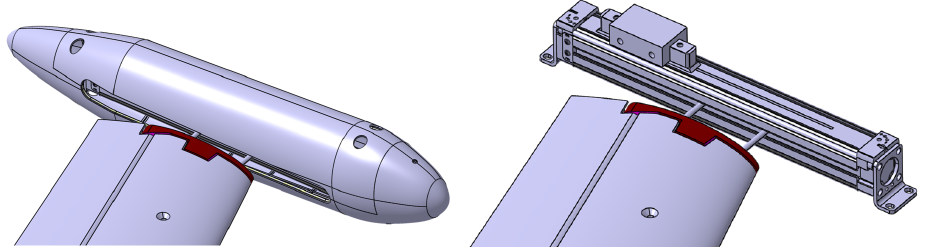
Figure 3. Anti-flutter device (internal and external